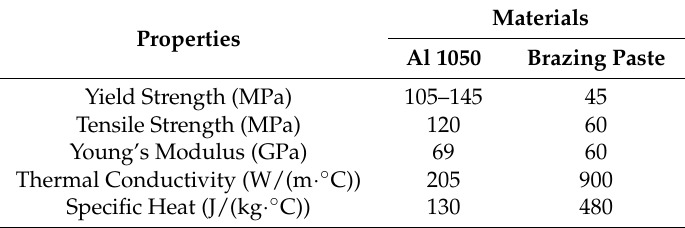
Table 1. Mechanical and thermal properties of materials.